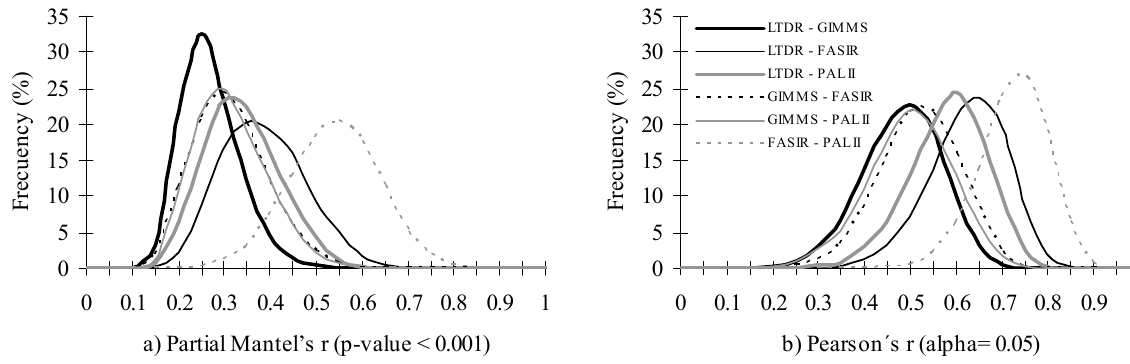
Figure 3. Comparison of the (a) spatial similarity (partial Mantel’s r) and (b) correlation (Pearson’s r) of the significant NDVI trends (p-value < 0.05) between pairs of the four AVHRR datasets in the Iberian Peninsula. The frequency histograms of Pearson’s and partial Mantel’s r resulted from 10000 bootstrapped tests using random subsamples of 100 pixels. Significant values of r were considered for p-values <